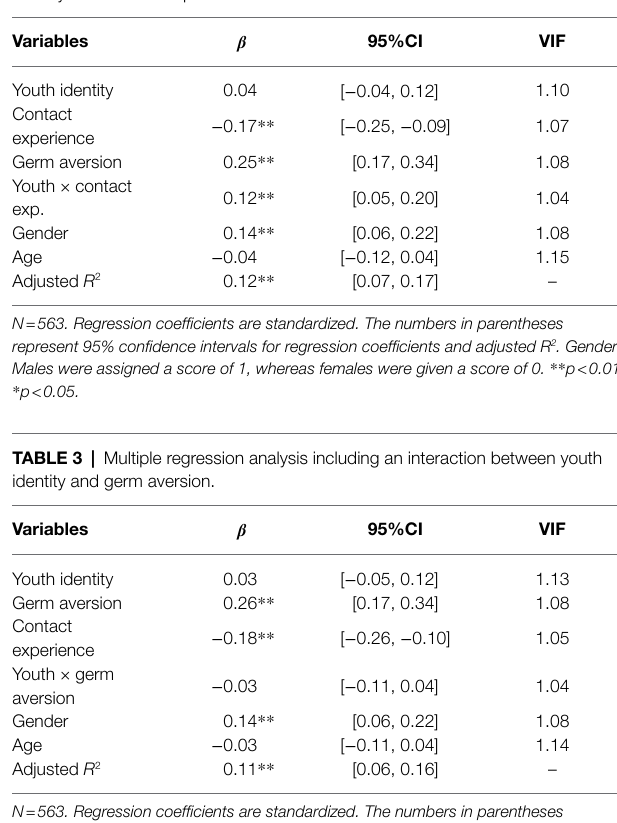
N = 563. Regression coefficients are standardized. The numbers in parentheses represent 95% confidence intervals for regression coefficients and adjusted R 2 . Gender: Males were assigned a score of 1, whereas females were given a score of 0. ** p < 0.01, * p <